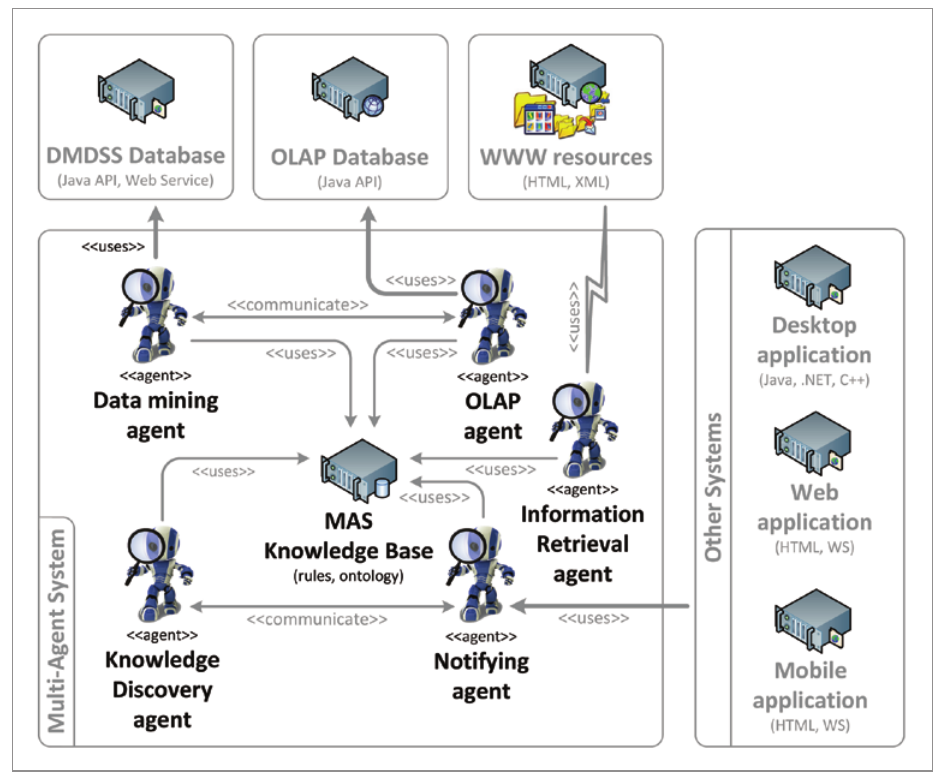
Fig. 1. Architecture of MAS used for Decision Support in